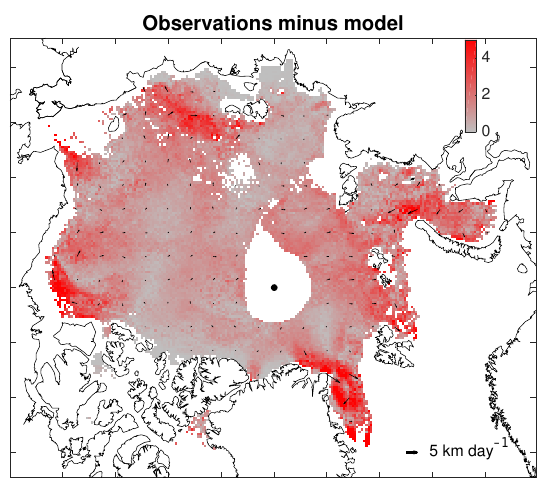
Figure 7. Difference between the observed and simulated mean ice drift shown on Fig. 6. The cells with less than 30 observations over the winter are masked. Systematic errors are located in the Beaufort Gyre and Fram Strait and in some areas of the Kara, East Siberian, and Chukchi seas. In the rest of the domain the error on the mean winter drift is only about 1kmday − 1 .